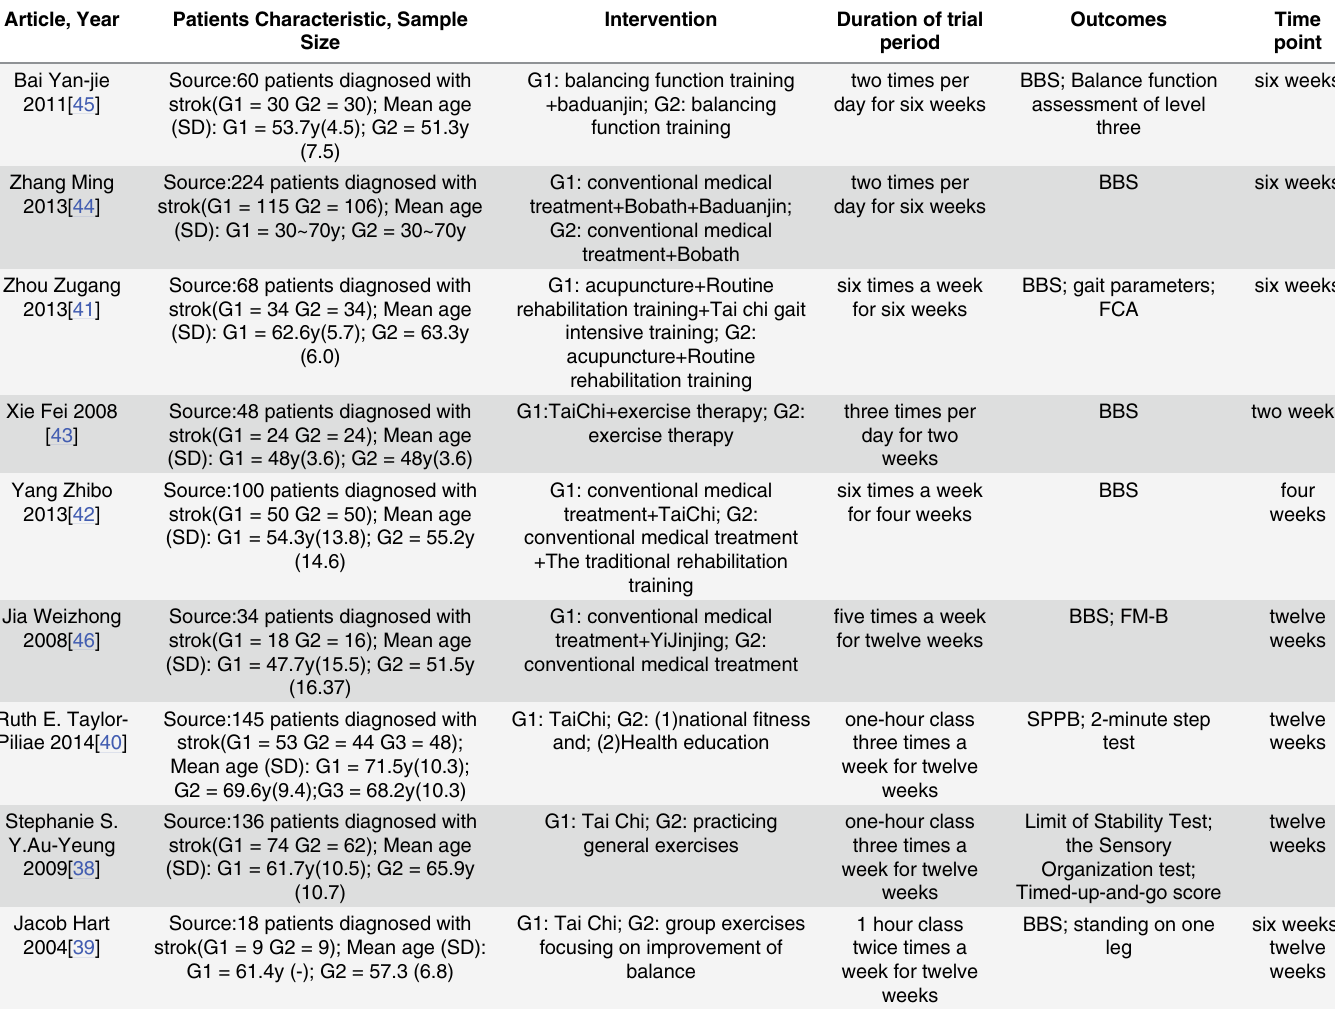
Table 1. Characteristics of Included Studies. Article, Year Patients Characteristic, Sample